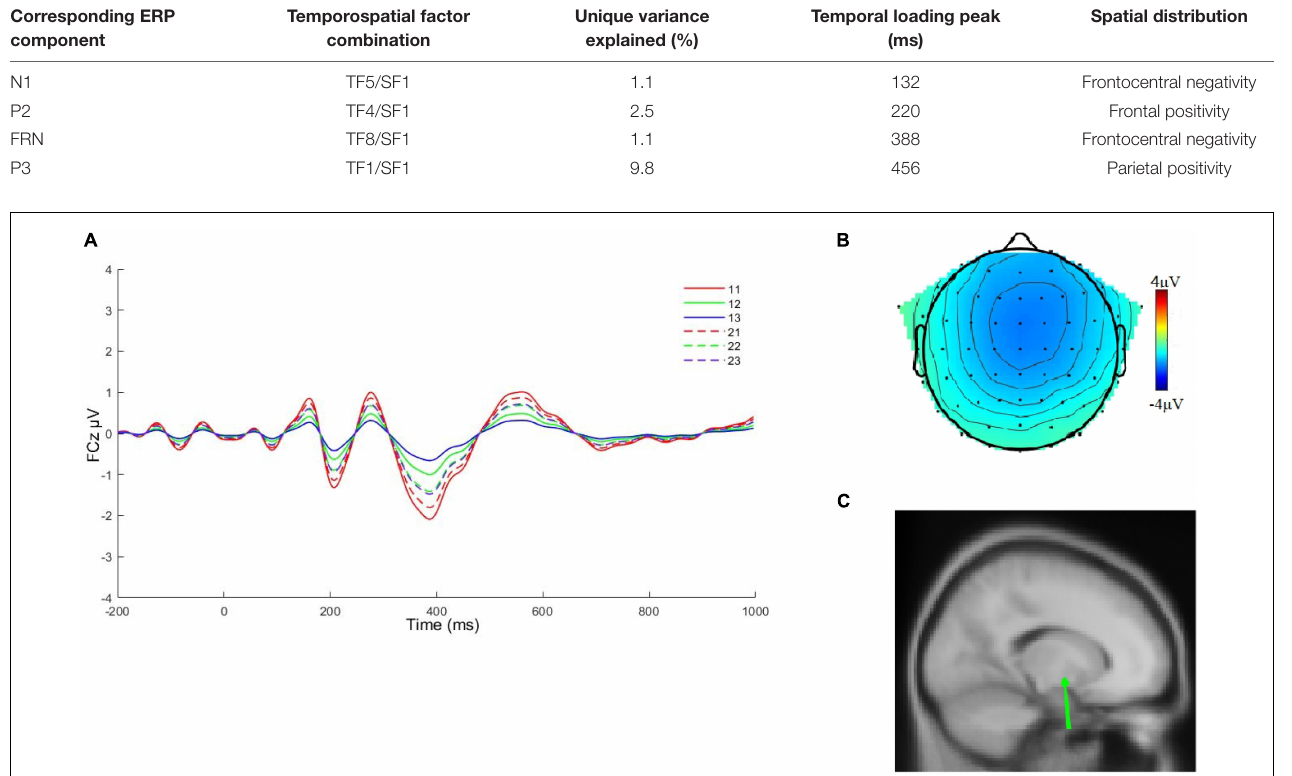
TABLE 3 | Principal component analysis (PCA) factor combinations selected for statistical analysis. Corresponding ERP component